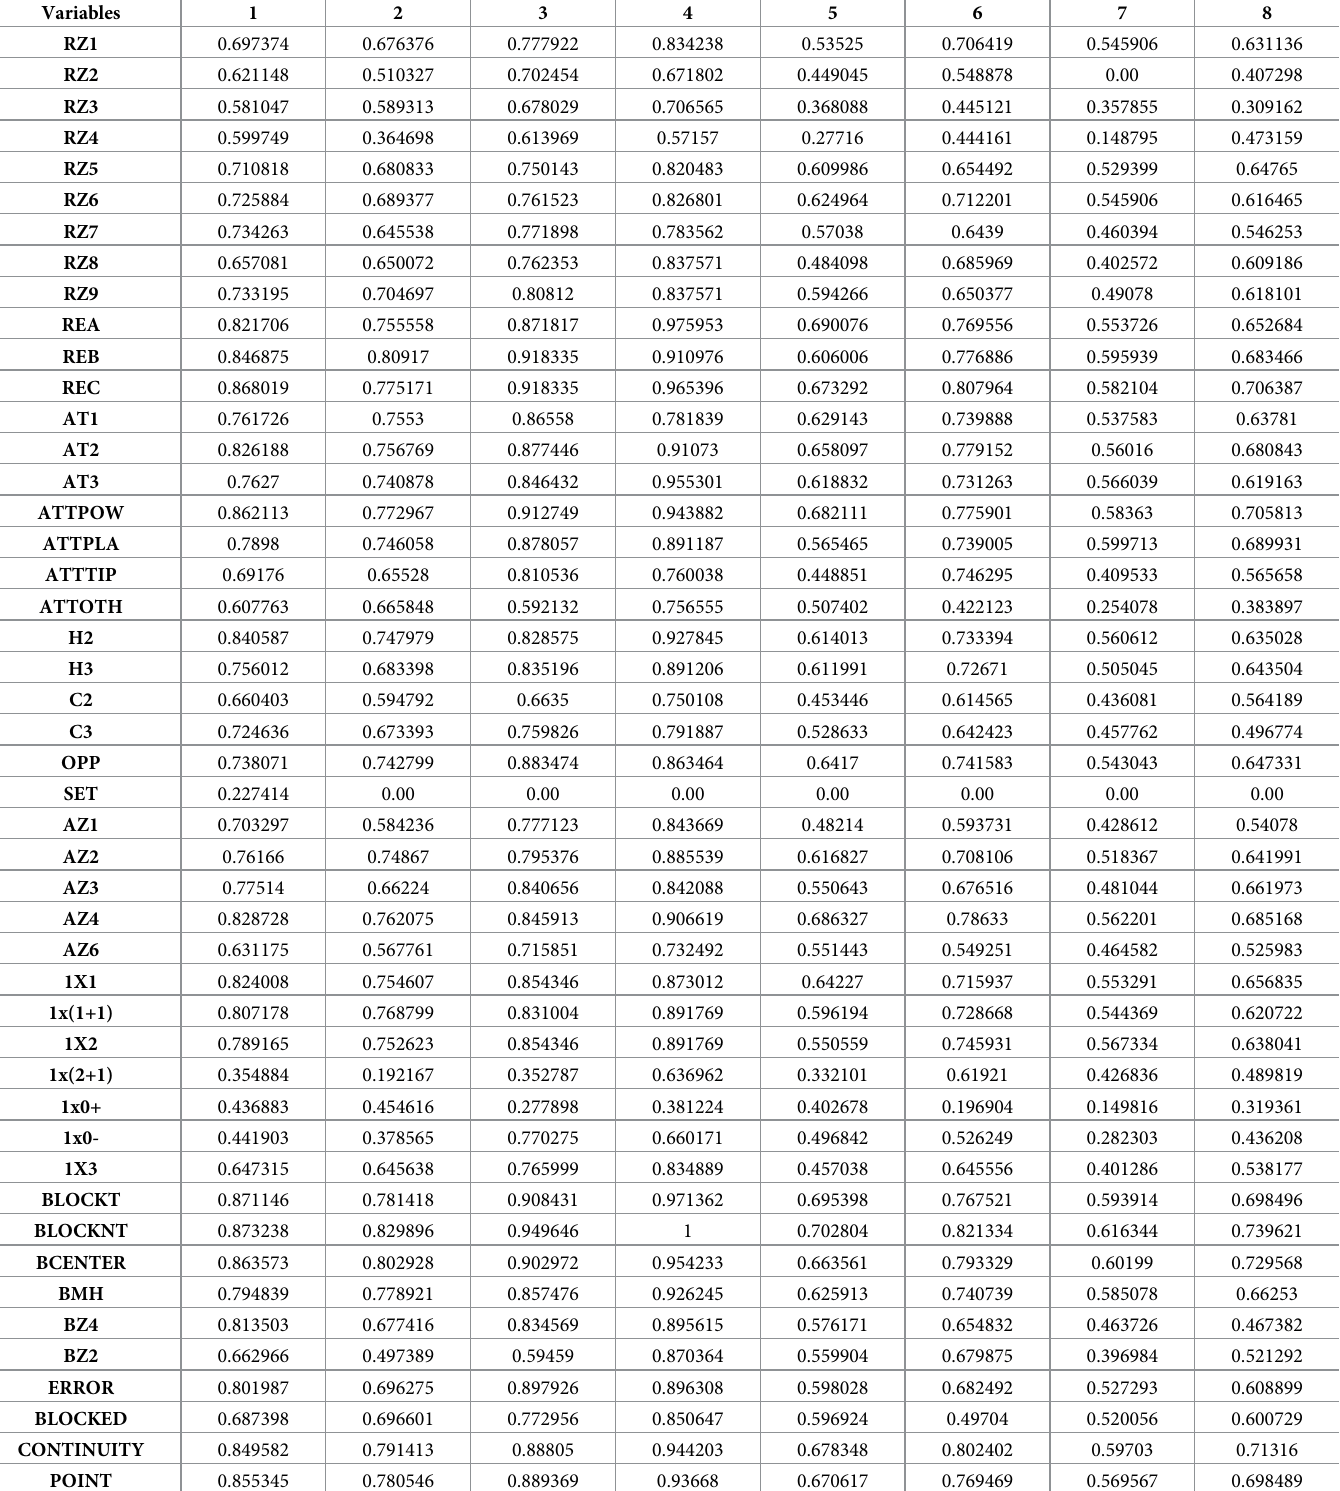
Table 1. Eigenvector values for each